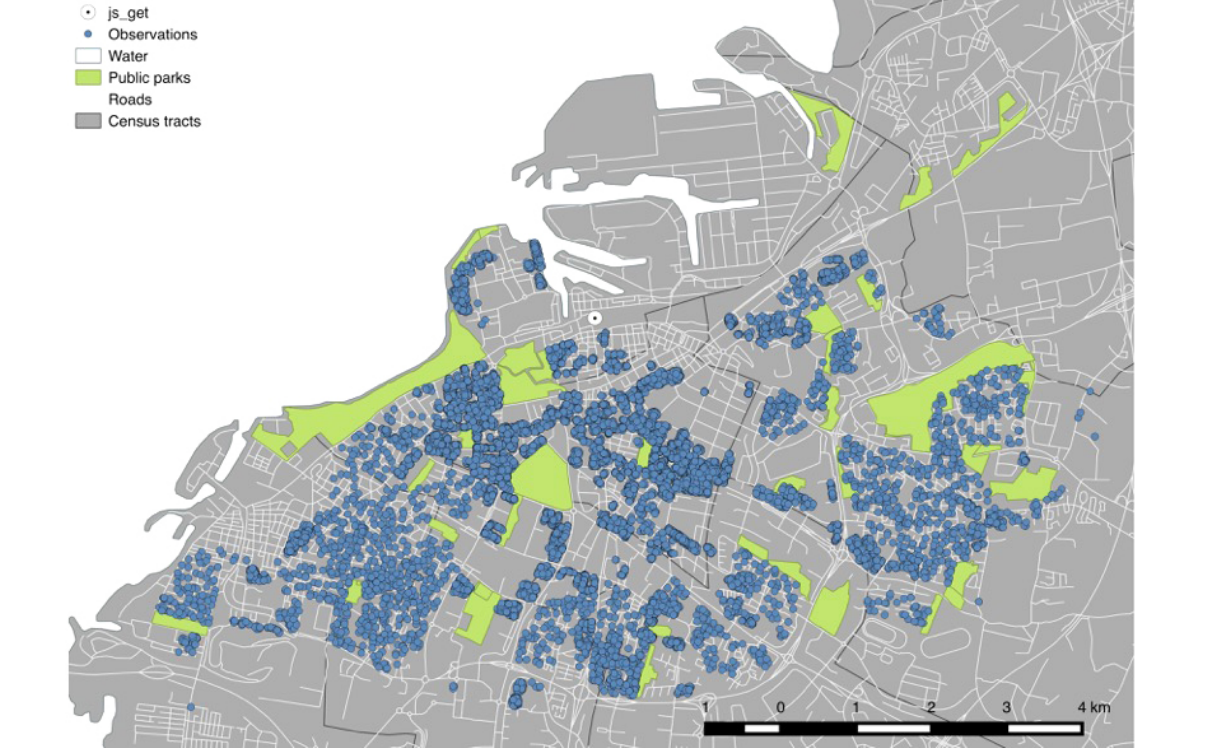
Fig. 1 . Map of Malmö municipality including parks, census tracts, and observations. See legend for